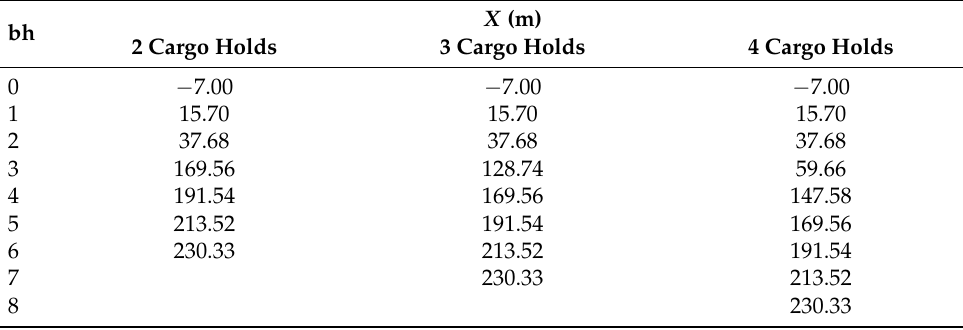
Table 4. Position of the bulkheads obtained through optimisation